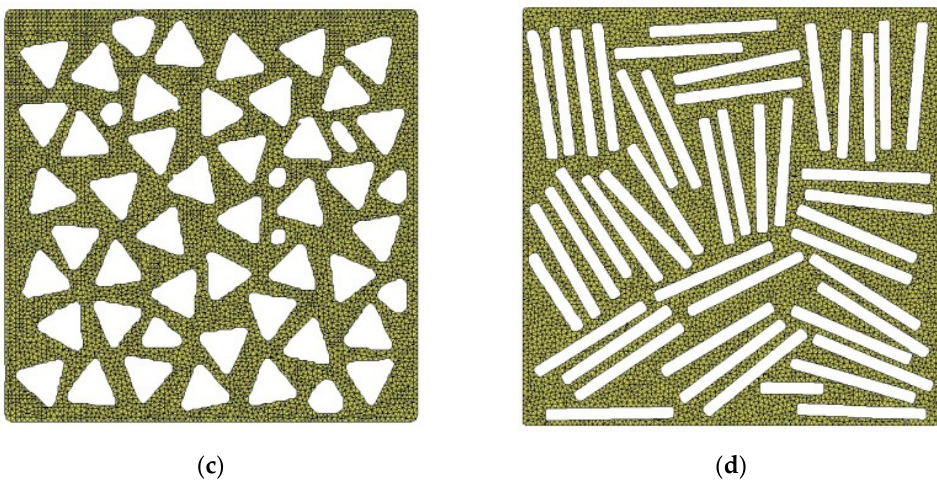
Figure 10. Models with different pore sphericity: ( a ) SI = 1; ( b ) SI = 0.886; ( c ) SI = 0.778; ( d ) SI = 0.600.